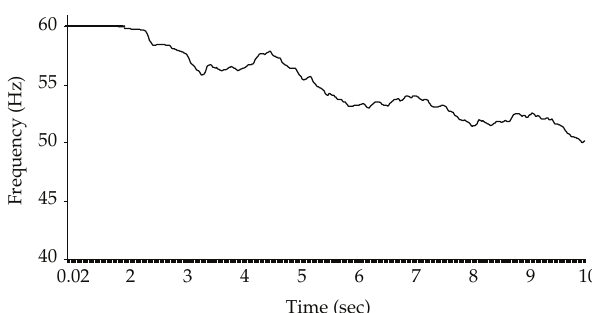
Figure 8: The buses average frequency decline due to the fault at line 4.